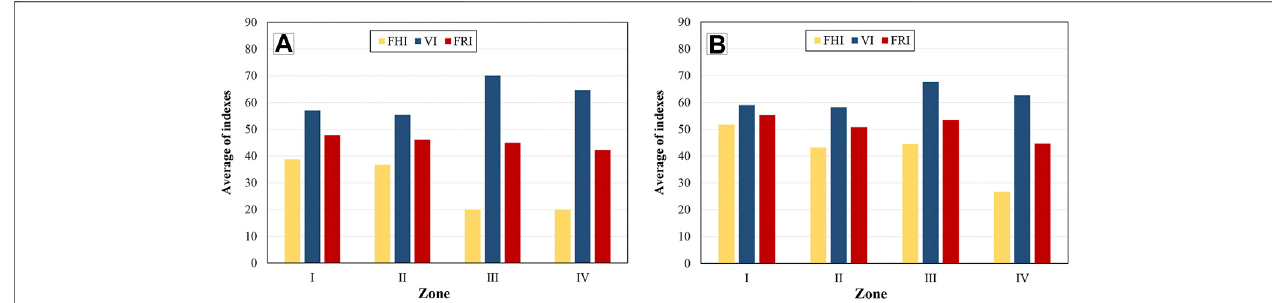
FIGURE 13 | Average FHI, VI, FRI of each zone in the fl ood scenarios with (A) 50-year and (B) 100-year R T .